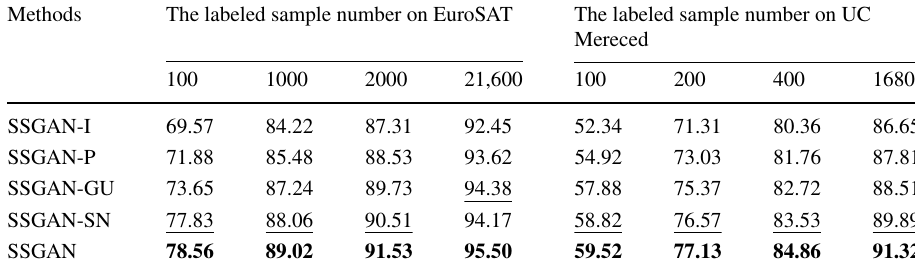
The bold indicates the highest accuracy, and the italic indicates the second highest